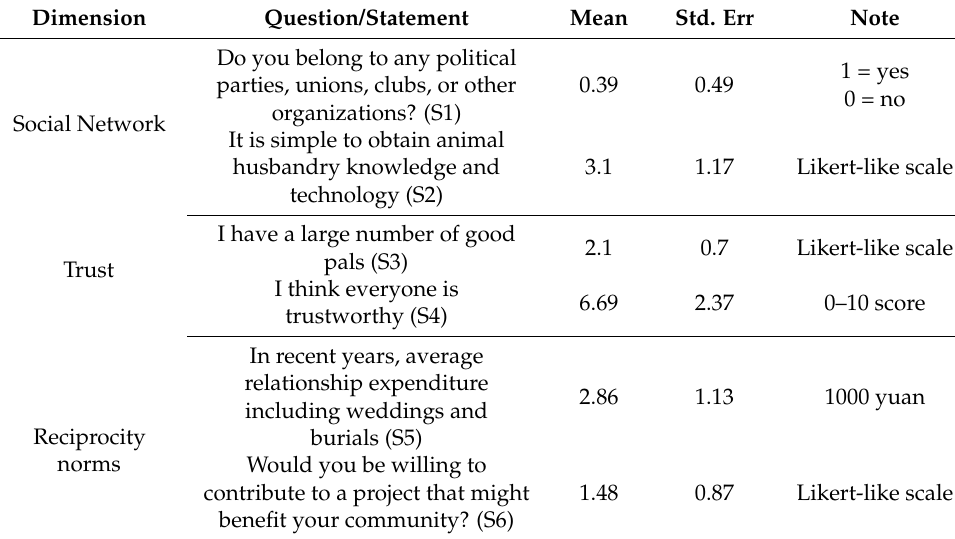
Table 2. Measurement of herders’ social